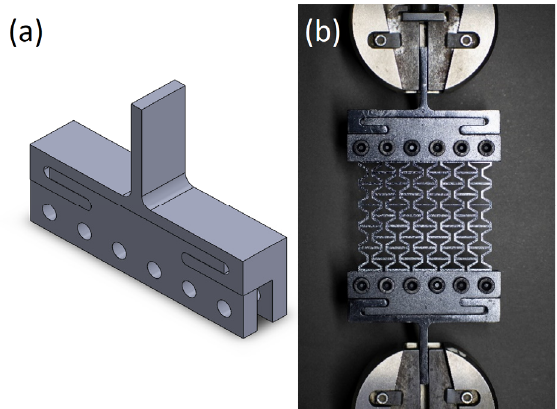
Figure 6. ( a ) Custom mount for holding the structure and ( b ) tension testing setup.